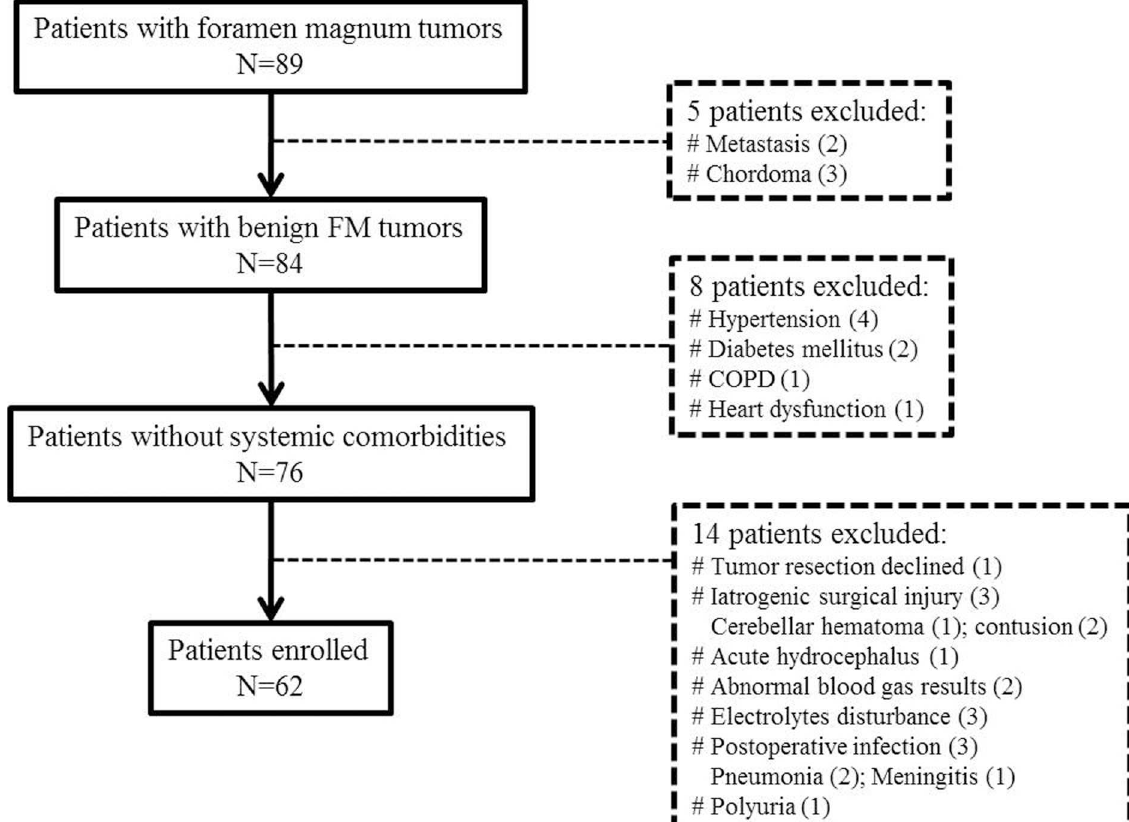
Fig 1. Flowchart of patients enrollment. COPD, chronic obstructive pulmonary disease; FM, foramen magnum.